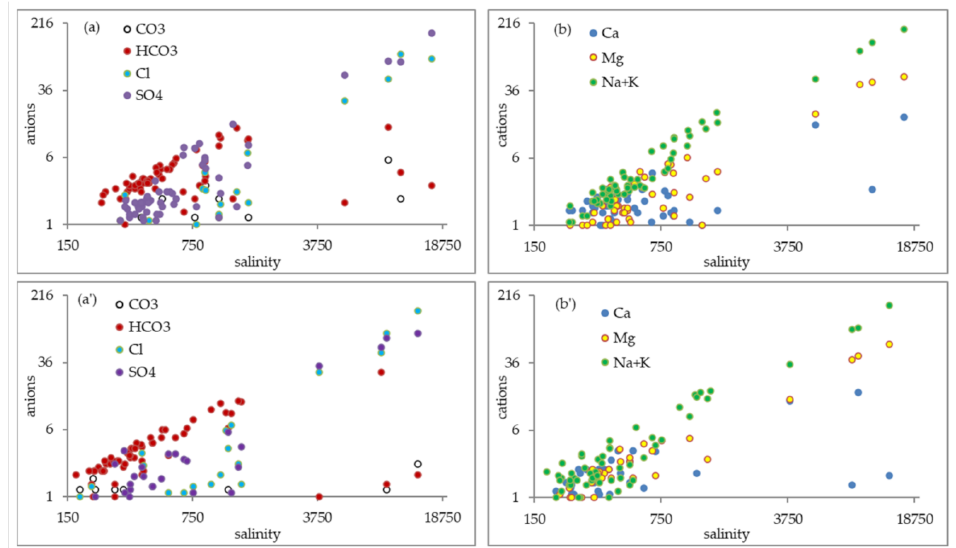
Figure 9. Ion distribution in relation to salinity: anions—( a )—pre-vegetation, cations ( b )—pre- vegetation, anions—( a’ )—post-vegetation, cations—( b’